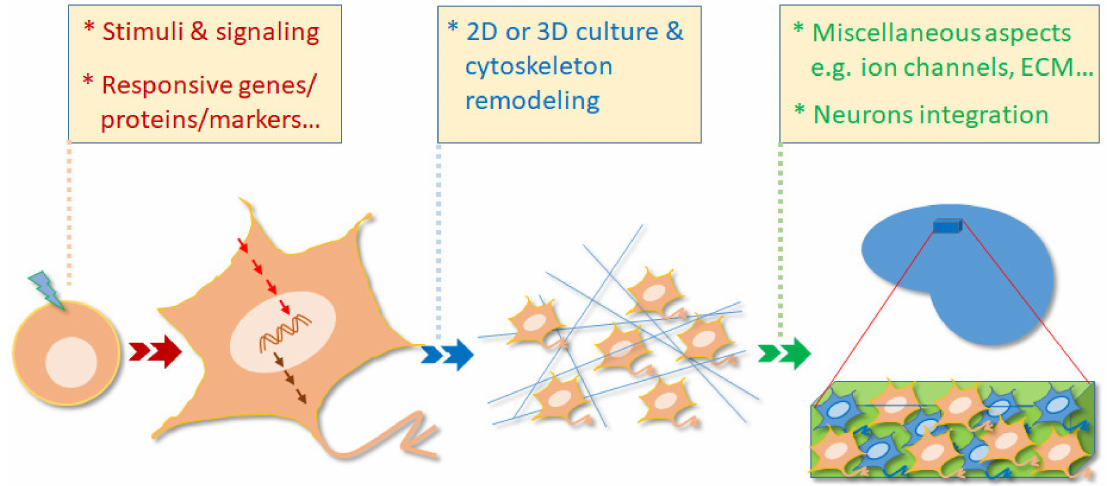
Figure 1. The ESC-derived glutamatergic neurons provide a great model for the study of differentiation. During differentia- tion, various stimuli, a range of relevant signaling molecules, and various responsive genes/protein/markers are able to be conveniently investigated in vitro. Furthermore, these glutamatergic neurons are also able to be cultivated in either a 2D environment or in a 3D matrix in order to study cytoskeleton remodeling and morphological changes. When these neurons are grafted into brain tissue, neuronal integration, ion channel expression, extracellular matrix secretion, as well as many other aspects, are able to be explored from a functional point of